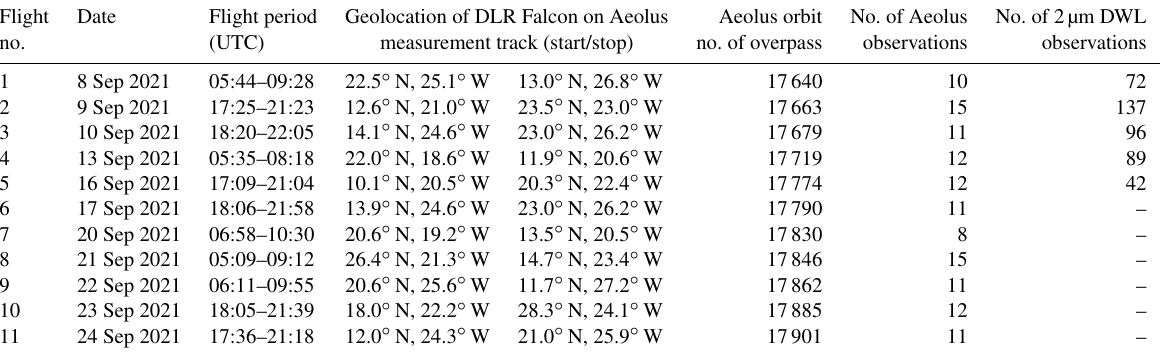
Table 1. Overview of the Aeolus underflights of the Falcon aircraft in the frame of the AVATAR-T campaign in September 2021 and the wind observations performed with the 2µm DWL along the Aeolus measurement